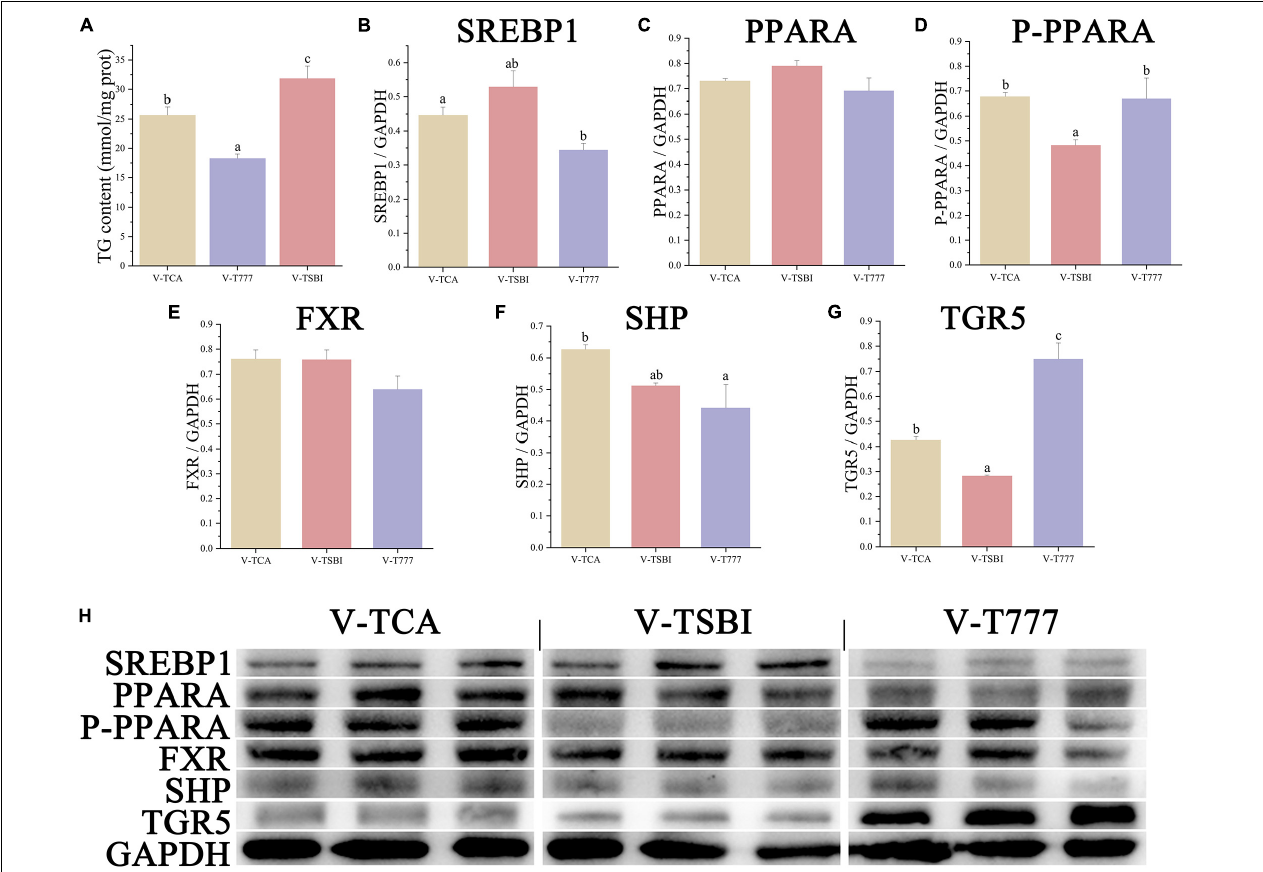
FIGURE 7 | The lipid accumulation and metabolism of hepatocytes in TGR5 agonist or antagonist incubation. (A) The content of intracellular TG ( n = 9). (B–G) The relative quantification of protein levels normalized to GAPDH in hepatocytes ( n = 3). (H) The Western blot band of hepatocyte samples ( n = 3). Values are presented as means with SD, where significant ( p < 0.05) differences between groups are indicated by different letters.